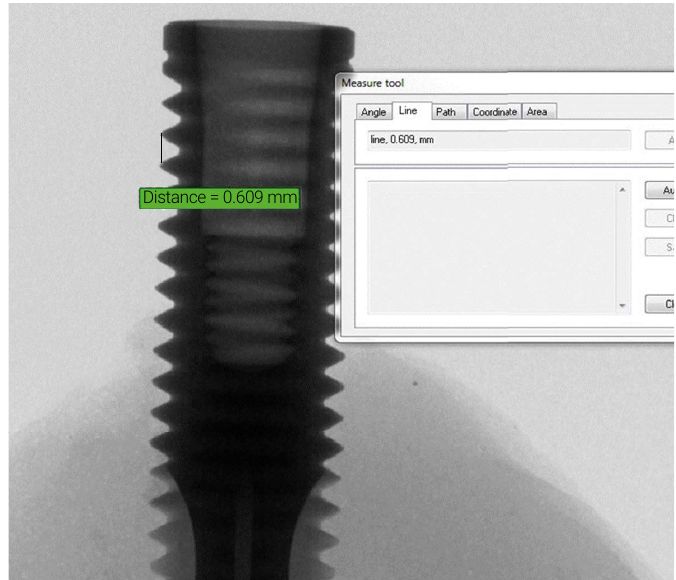
Figure 3. Micro-CT constructed image and measure tool utilization.